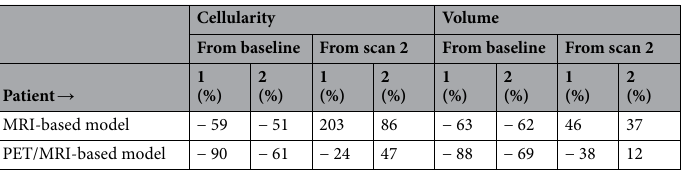
Table 2. Modeling results for the predicted percent change in tumor response from baseline and scan 2 to the time of surgery.